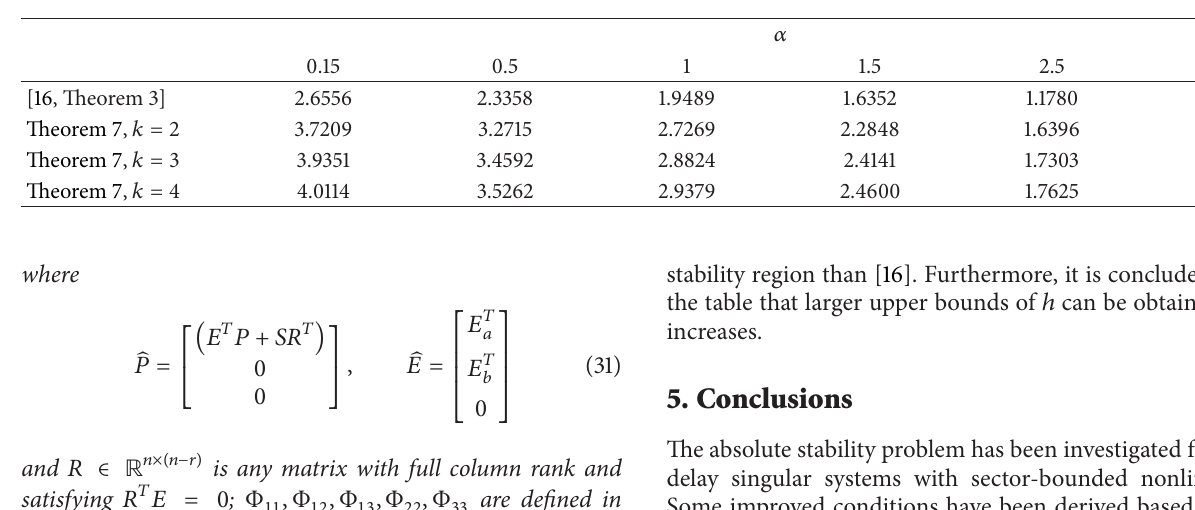
Table 1: Maximum upper bounds of ℎ